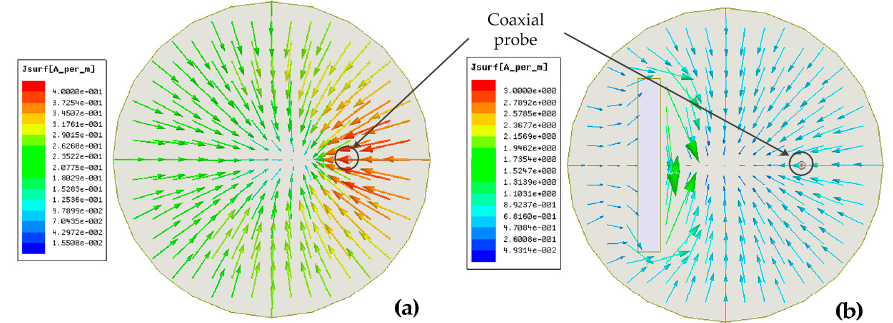
Figure 3. Coaxial line-feed dielectrically-loaded cylindrical resonator in the TM 010 mode ( a ) without the aperture and ( b ) with the aperture.